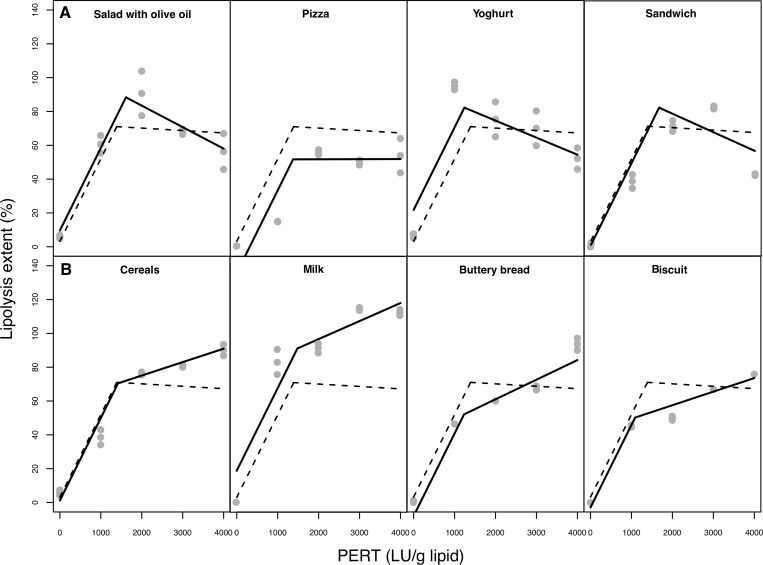
Lipolysis extent (%) as a function of PERT dose (LU/g lipid) predicted for each food by applying the segmented mixed regression model.The dotted line represents the evolution considering all the foods together and the solid line shows the estimation for each food individually. Fig 2A: foods with a decreasing lipolysis extent with dose; Fig 2B: foods with an increasing lipolysis extent with dose.